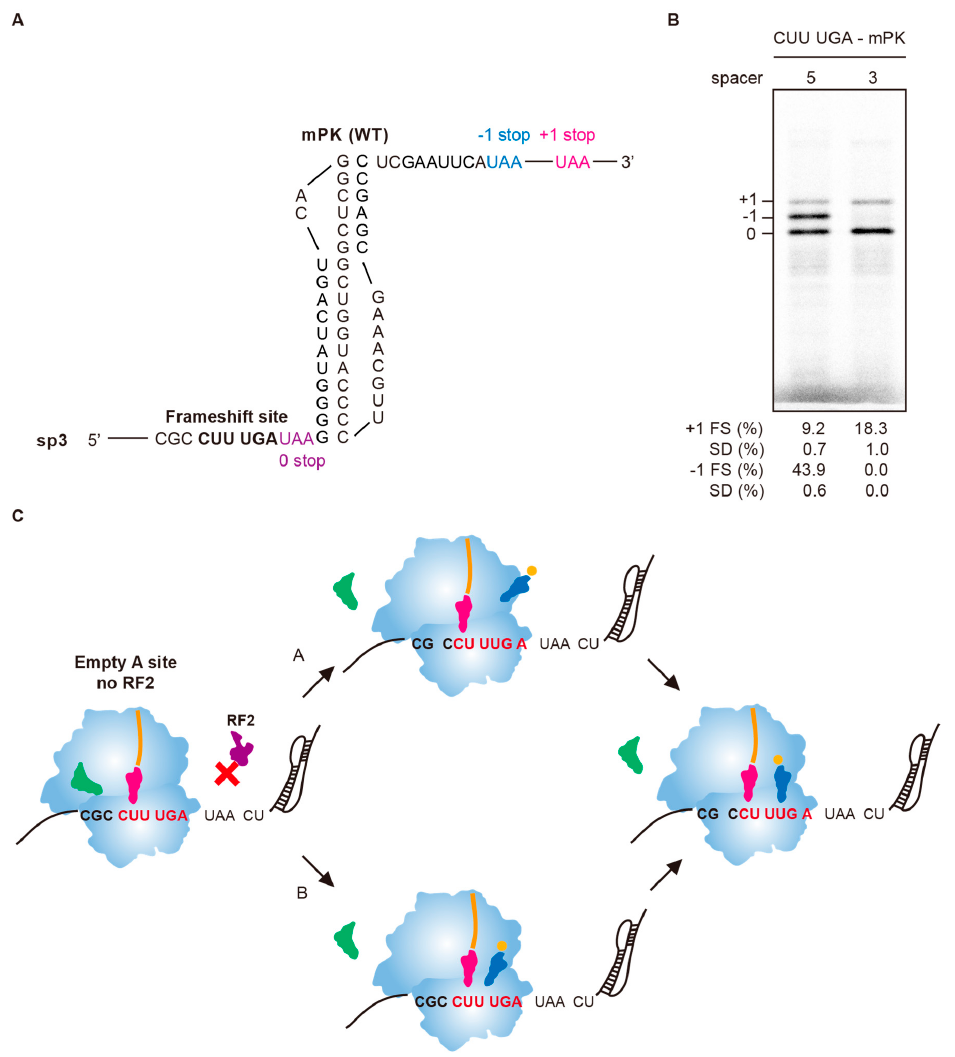
Figure 6. The downstream mPK stimulates − 1 frameshifting with a five-nucleotide spacing toward the A-site sitting UGA codon. ( A ) The sequence and predicted structure of sp3 construct. ( B ) Radioactivity-based frameshifting assays of the sp3 construct (corresponding to spacer 3 model) compared with the CUUUGA-mPK construct (corresponding to spacer 5 model) in Figure 3A. Calculated − 1 and +1 PRF efficiency values displayed are means ± SD of three independent experiments. ( C ) Proposed mechanisms of the non-canonical − 1 PRF in the absence of RF2. The proposed mechanisms put the UGA stop codon in the A-site, resulting in a spacer of 5 nts to mPK while the CUU codon is sitting in the P-site based on the data from ( B ) as well as the requirement of RF2 deficiency for the non-canonical − 1 frameshifting. This positioning allows the downstream mPK to stimulate − 1 frameshifting through two alternative pathways with differences in the sequential order of peptidyl-tRNA movement from 0-frame to − 1 frame. In pathway A, the 0-frame peptidyl-tRNA moves from CUU to − 1 frame CCU and thus positions the UUG codon in the A-site. In pathway B, an incoming charged tRNA samples the available reading-frames while peptidyl-tRNA is sitting in the 0-frame P-site and is paved by two identical nucleotides bridging E- and P-sites that favors − 1 frame accommodation of peptidyl-tRNA to facilitate − 1